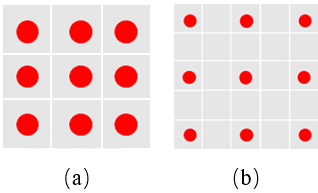
Figure 1. Examples of ordinary convolution and atrous convolution. Red dots in the grid represent weights, and non-red dots indicate that the grid has a value of 0: ( a ) an ordinary convolution with the size of 3 × 3; and ( b ) an atrous convolution with the size of 3 × 3 and the dilation rate of